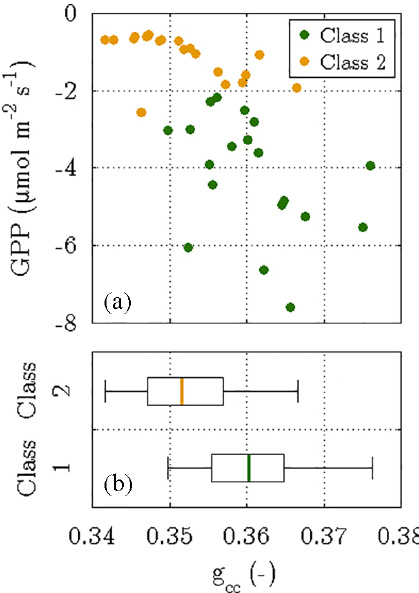
Figure 9. Outcome of the phenocam approach, i.e. determining the green chromatic coordinates ( g cc ) of two target areas in time-lapse images that were taken between 18 June and 6 July 2014. The g cc values were computed for both vegetation classes and depict the fraction of the green colour in relation to the three primary colours in the RGB colour space. While the scatter plot (a) displays daily means of photosynthesis versus their corresponding g cc values, the box plots (b) visualise the difference in the distribution of g cc values between both vegetation classes. The significantly greater greenness in vegetation class 1 was associated with larger photosynthetic rates, whereas vegetation class 2 was characterised by a less green canopy and thus a lower photosynthetic activity ( P < 0 .